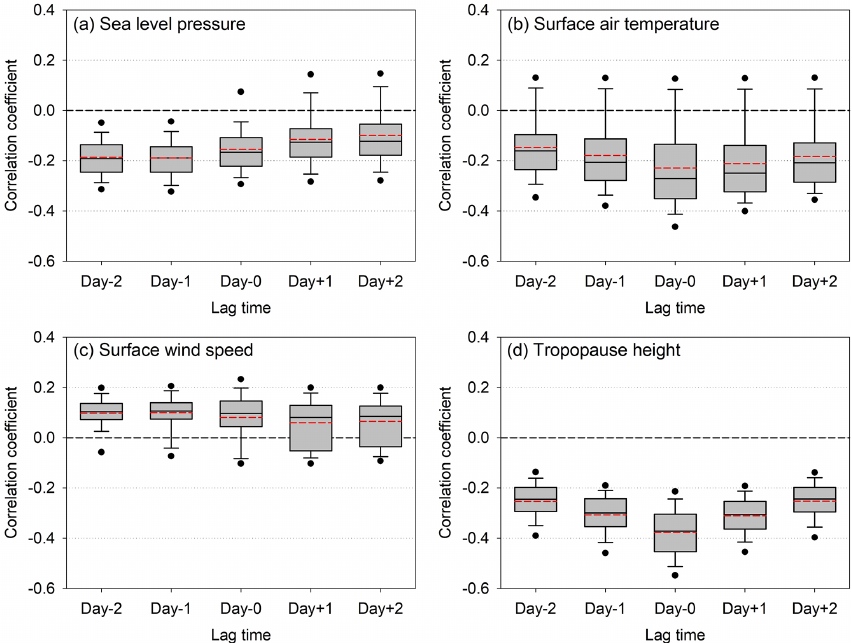
Figure 21. Box and whisker plots of the time-lagged correlation between the total BrO VCD and each meteorological parameter (a) sea level pressure, (b) surface air temperature, (c) wind speed at 10m, and (d) tropopause height in the Arctic sea ice region. Time-lagged correlation coefficients performed in all reference grid cells with different time lags ( − 2, − 1, 0, + 1, and + 2d) are summarized. The 5th, 10th, 25th, 50th (median), 75th, 90th, and 95th percentiles of correlation coefficients are represented by the bottom filled circle, the lower whisker, horizontal lines of the box, the upper whisker, and the upper filled circle, respectively, and the mean value is shown as a dashed red line.